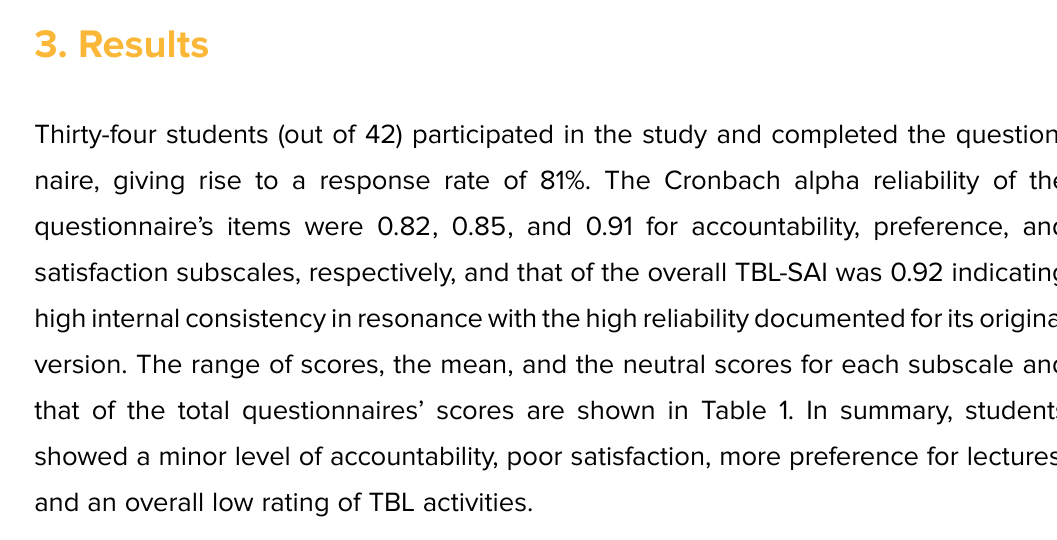
TABLE 1: Summary of the students’ scores in the three subscales of the TBL-SAI ( N = 34). Subscale Scores